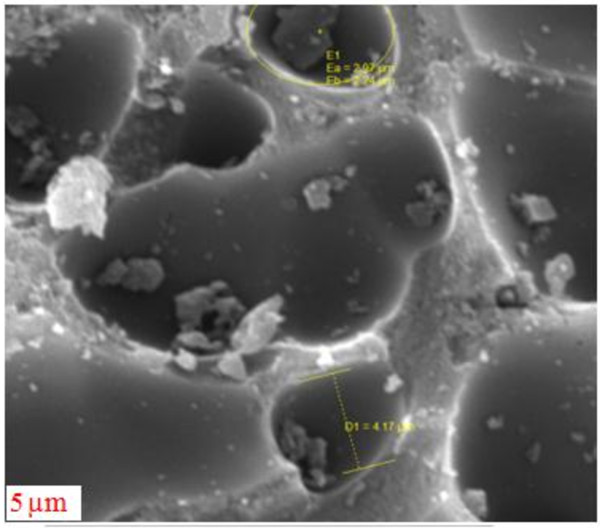
SEM image of modified granular activated carbon.